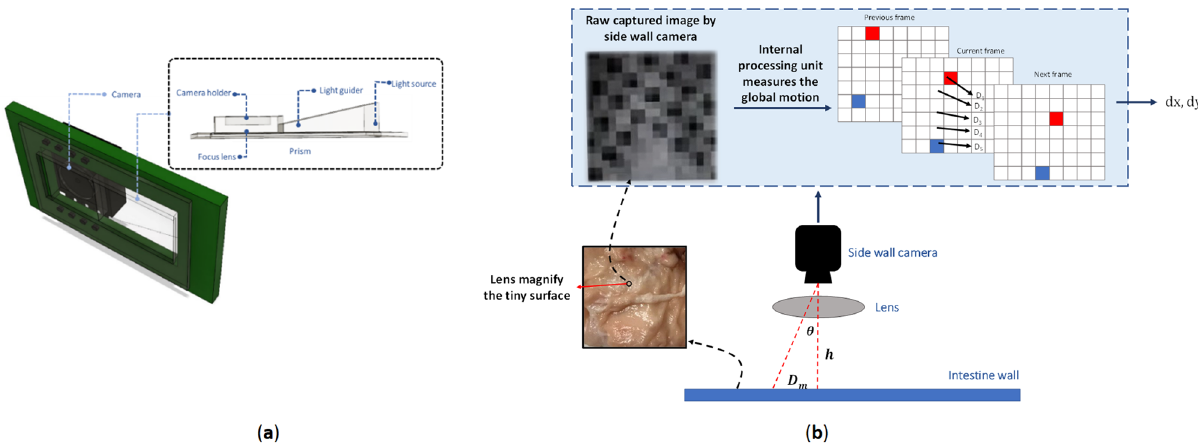
Figure 4. ( a ) Side wall camera and its optical parts, ( b ) global motion vector